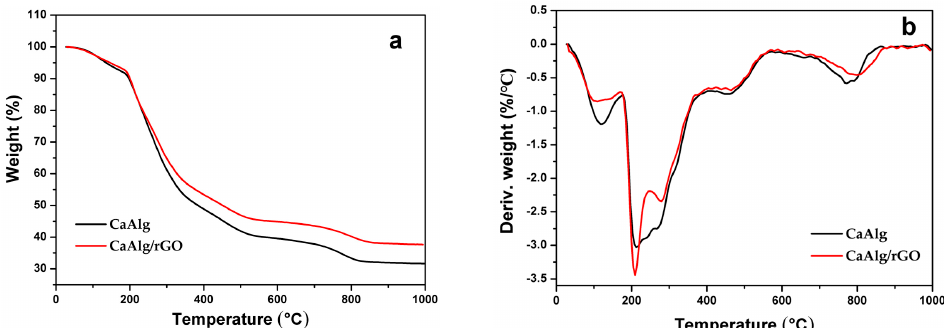
Figure 4. ( a ) Thermal gravimetric analysis (TGA) and ( b ) differential thermogravimetric analysis (DTG) of the CaAlg and CaAlg/rGO materials under N 2